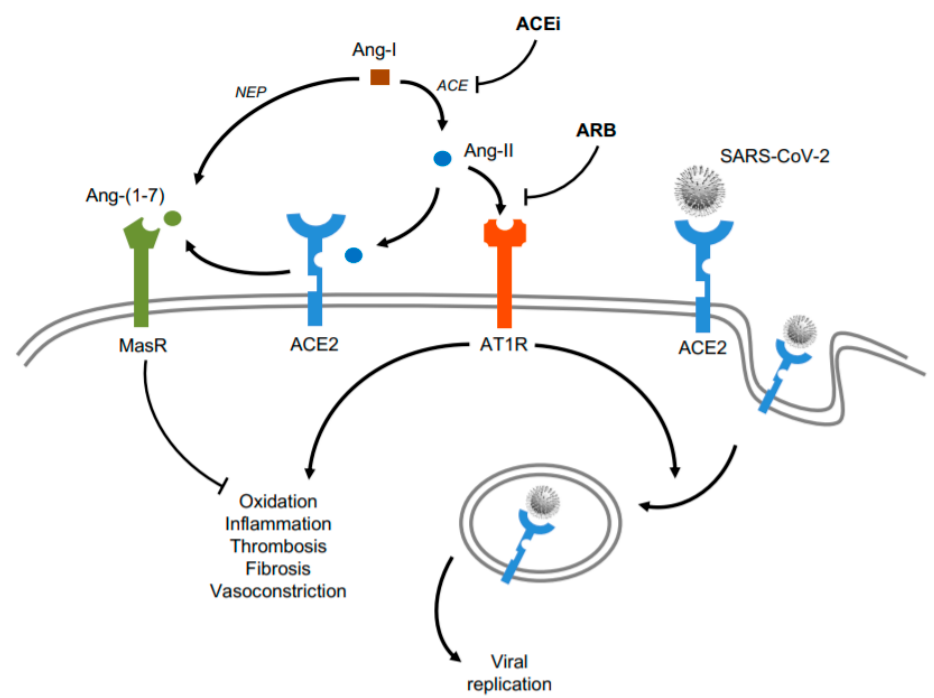
Figure 2. Role of ACEi and ARB in SARS-CoV-2 infection. In COVID-19, stimulation of the ACE / Ang-II / AT1R pathway of the renin-angiotensin-aldosterone system (RAAS) could activate the gene expression of pro-oxidation, pro-inflammation, pro-thrombosis, pro-fibrosis, and vasoconstriction. However, administration of ACEi or ARB drugs may block Ang-II actions, unbalancing the RAAS toward the ACE2/Ang-(1–7)/MasR axis, which conserves cardioprotective properties. Also, in infected cells, ACEi and ARB could reduce AT1R heterodimerization with ACE2, lessening internalization of the ACE2-SARS-CoV-2 complex and viral replication. Ang stands for angiotensin. NEP and ACE mean neprilysin, and angiotensin converting enzyme, respectively. MasR and AT1R